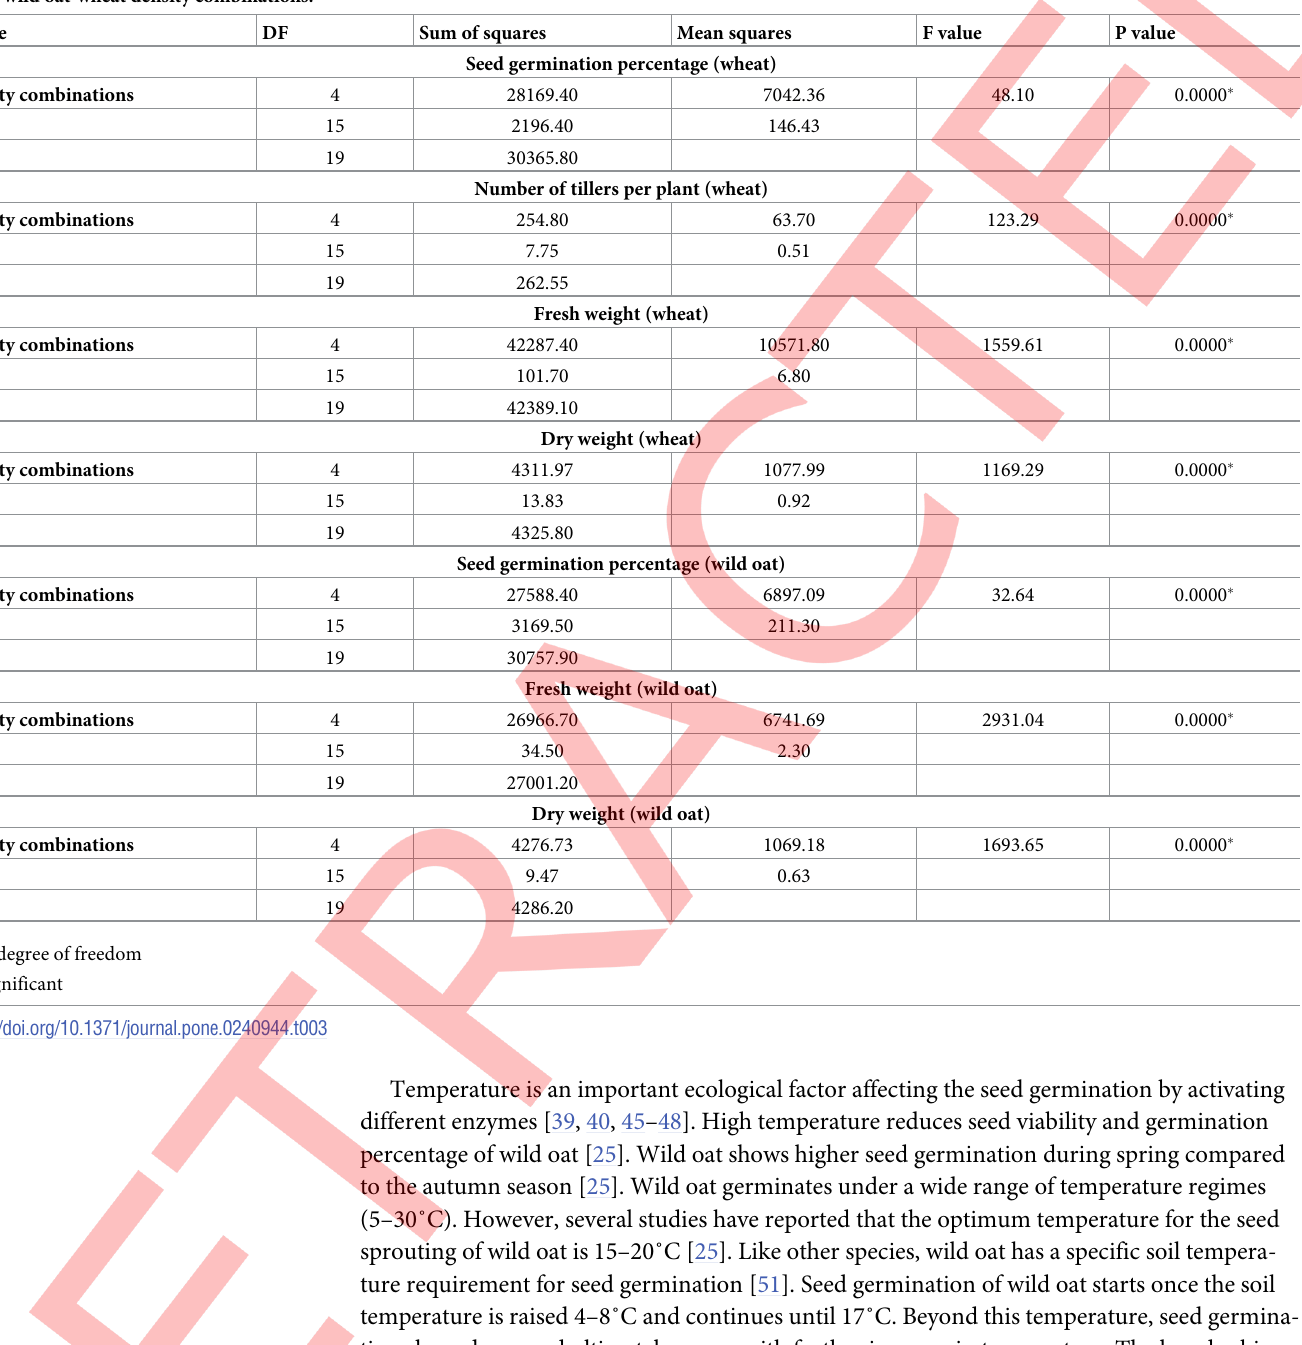
Table 3. Analysis of variance for seed germination percentage and fresh and dry biomasses of wild oat and wheat and number of tillers per plant of wheat under dif- ferent wild oat-wheat density